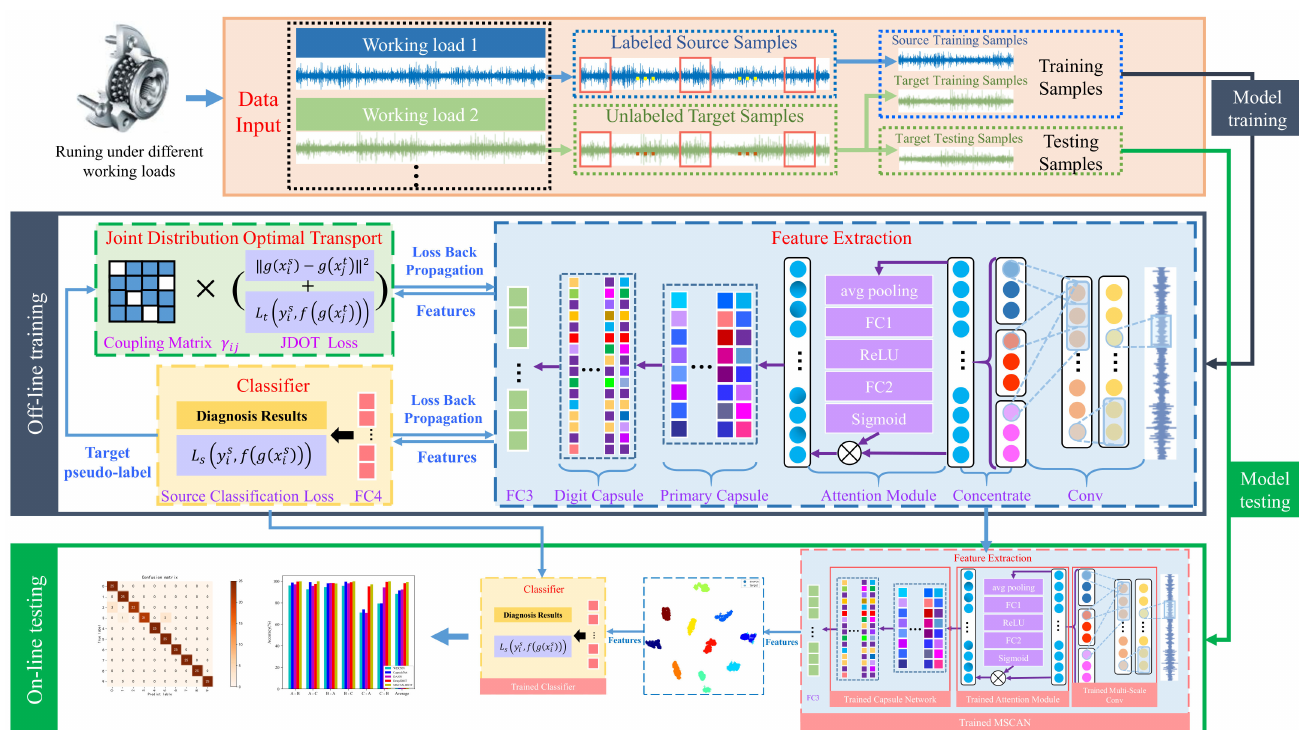
Figure 3. Flowchart of the